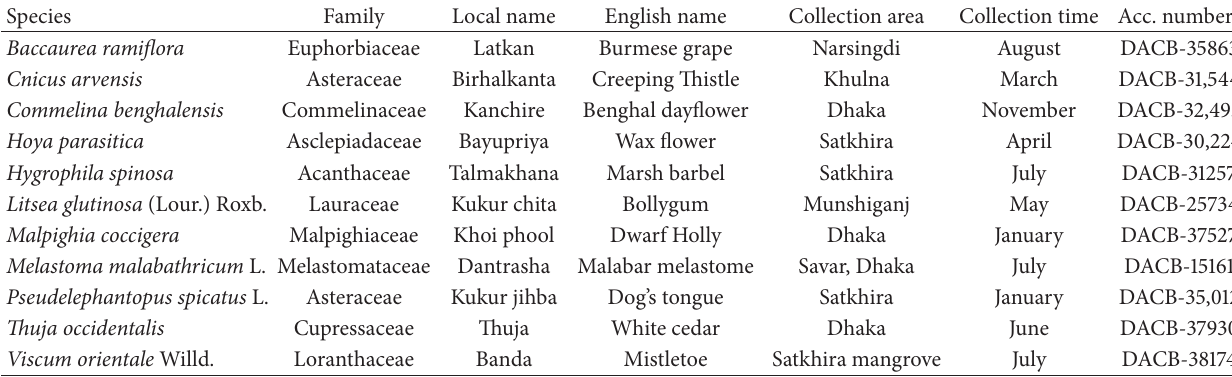
Table 2: Botanical information of eleven medicinal plants of Bangladesh.